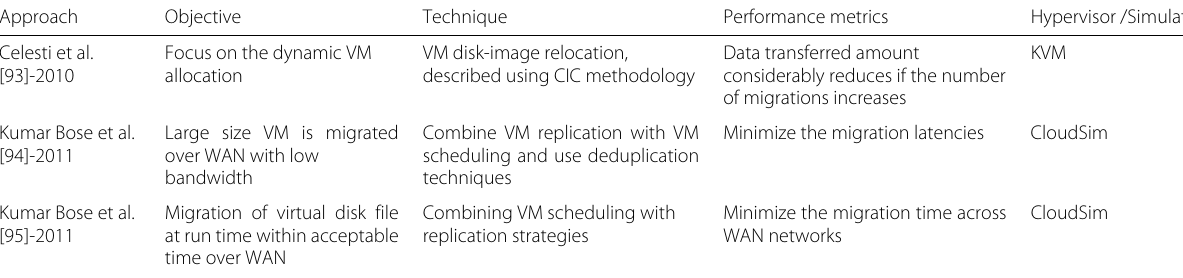
Table 6 Comparison of Replication based VM migration approaches